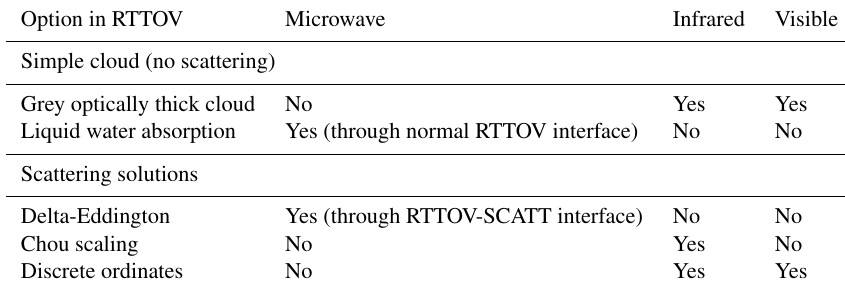
Table 2. Options in RTTOV for simulating the effects of cloud, precipitation and aerosols.